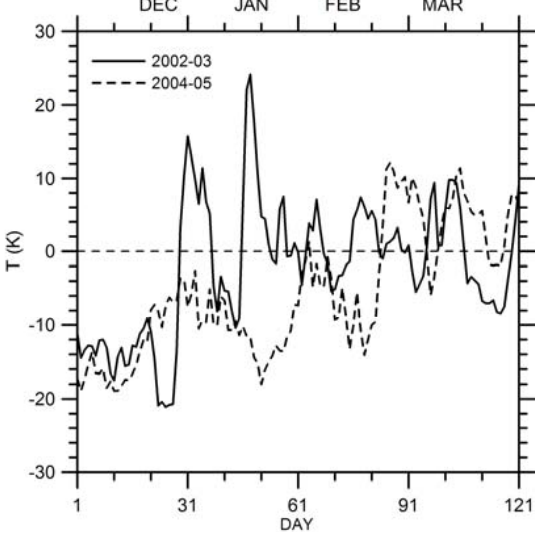
Fig. 4. Meridional gradient of zonal mean temperature (K) between 60 ◦ N and 90 ◦ N at 10hPa from 1 December to 31 March of winters 2002–2003 and